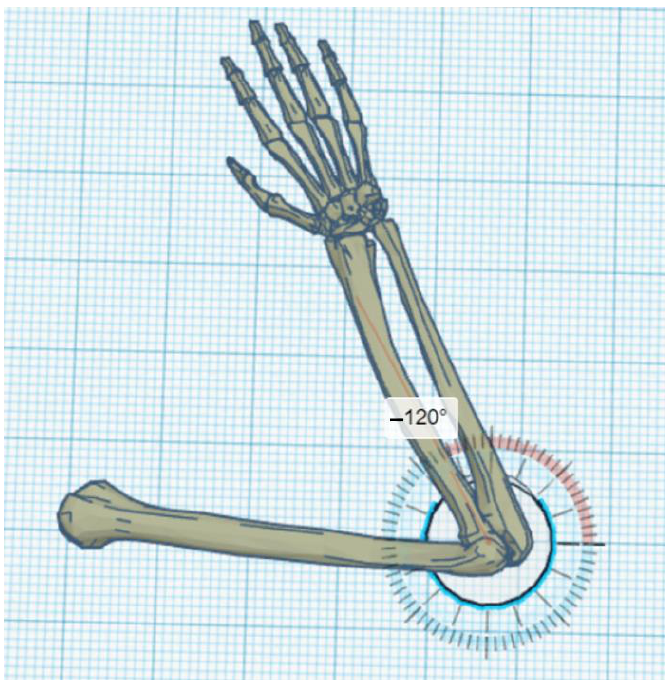
Figure 3. Maximum flexion of the elbow with a marked angle of rotation of 120 ◦